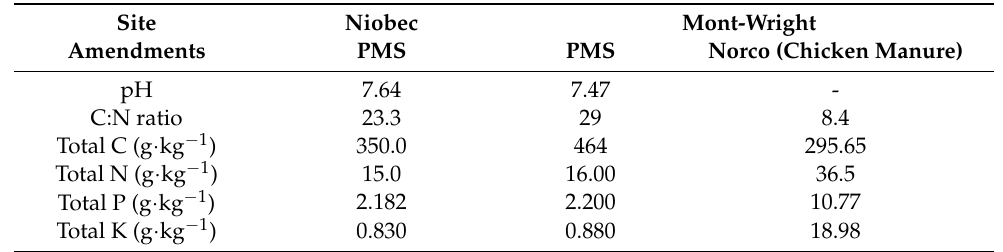
Table 1. Chemical characteristics of amendments used to reclaim tailing facilities at the Niobec and Mont-Wright tailing storage